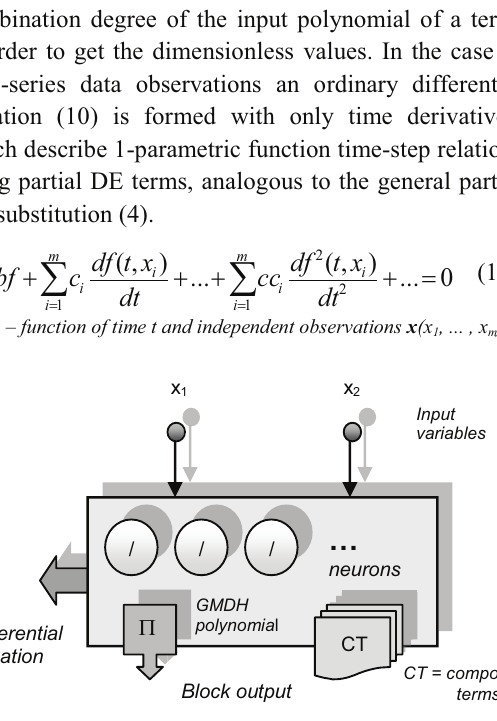
Fig. 2. D-PNN block involves simple and compound neurons (DE